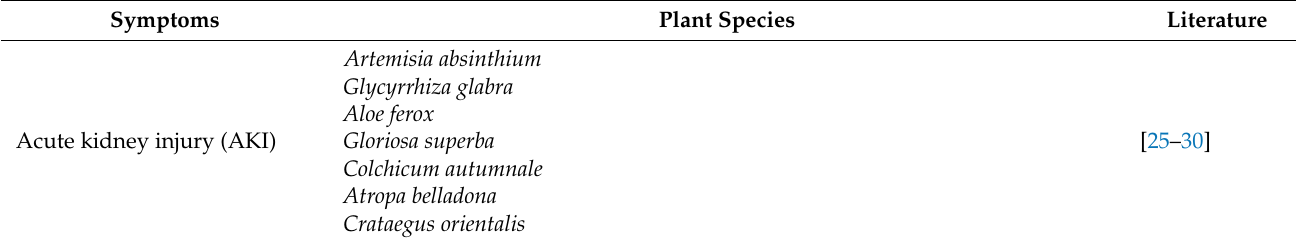
Table 2. Clinical manifestations of herbal-induced nephrotoxicity